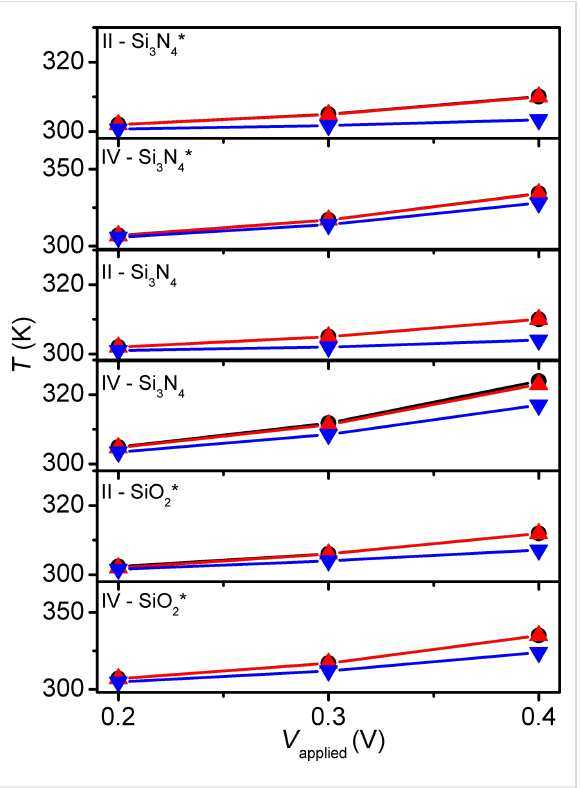
Figure 7: Results for different passivation materials. T peak (black circles), T free (red upward triangles) and T fixed (blue downward trian- gles), recorded for configurations II and IV from 0.2 to 0.4 V in positive polarity.